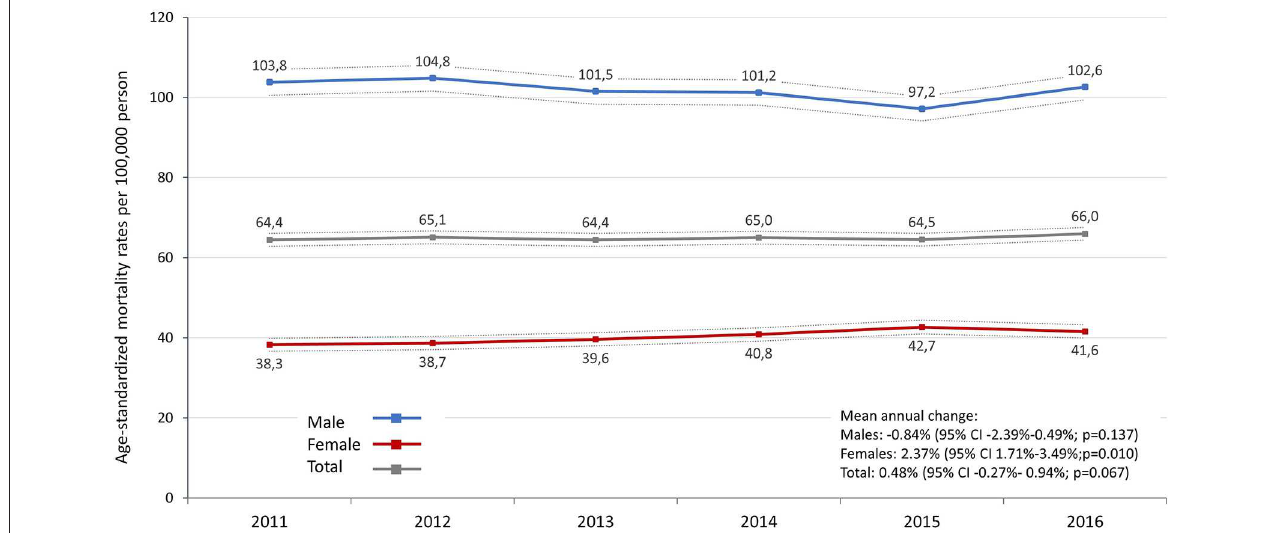
FIGURE 2 | Age-standardized mortality rates (standard: ESP 2013) of lung cancer by sex in Hungary between 2011 and 2016 (per 100,000 person-years; dotted lines represent the 95% CI). CI, confidence interval.